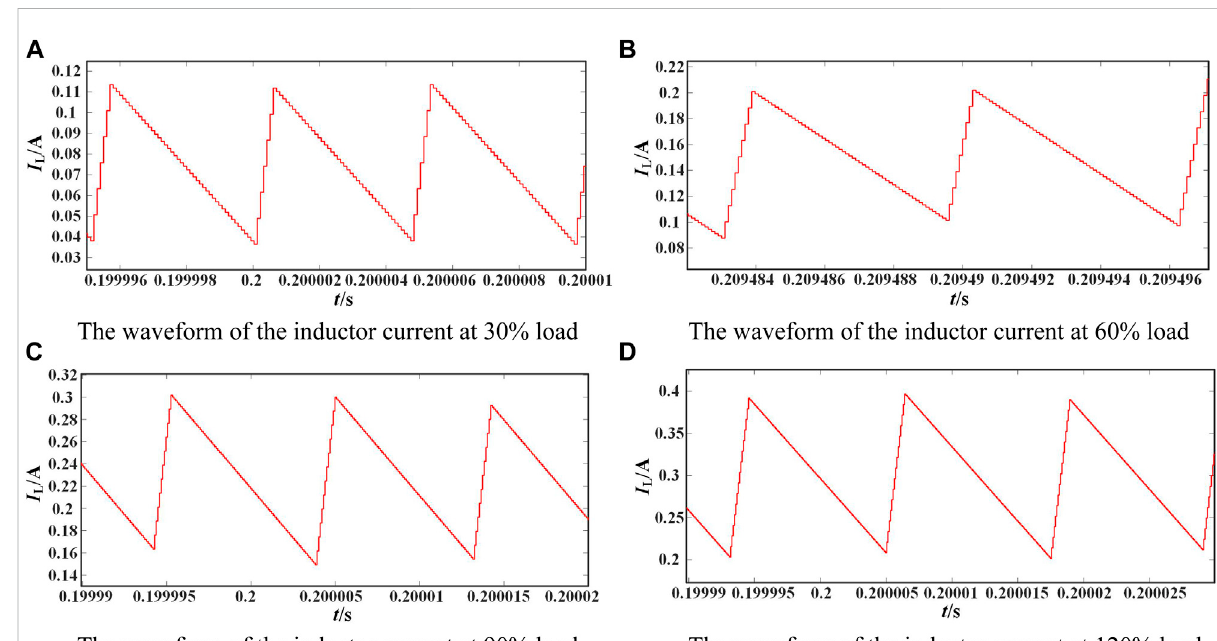
Inductor current waveforms with different loads in CCM at 3W rated power.